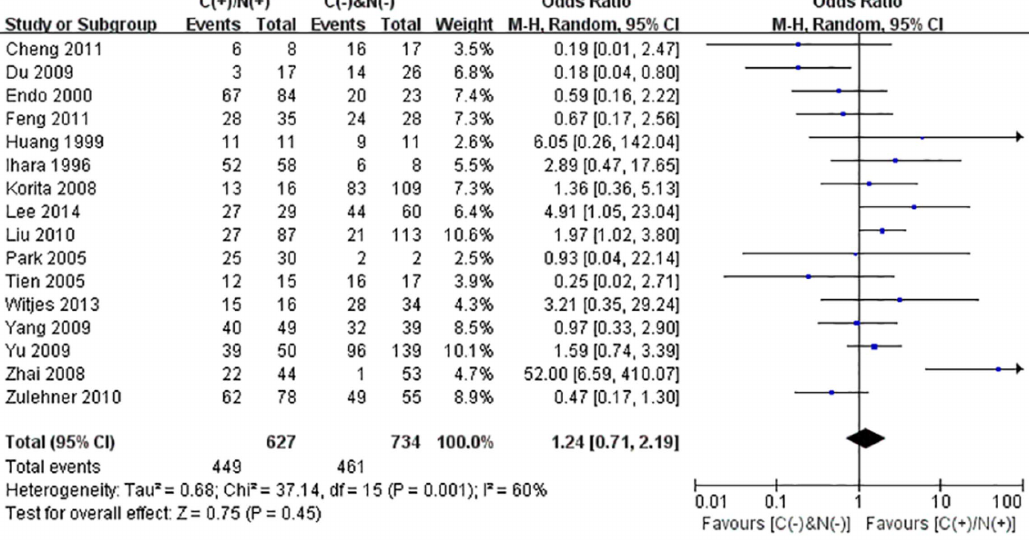
Figure 6. Forest plot of odds ratio for the association of b -catenin expression in cytoplasm and/or nucleus with differentiation grade.